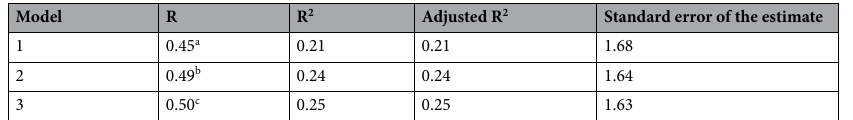
Table 2. GAD-2 regression model summary. a Predictors: (constant), Pre-GAD-2 sum. b Predictors: (constant), Pre-GAD-2 sum, age x gender. c Predictors: (constant), Pre-GAD-2 sum, age x gender, gender x child.